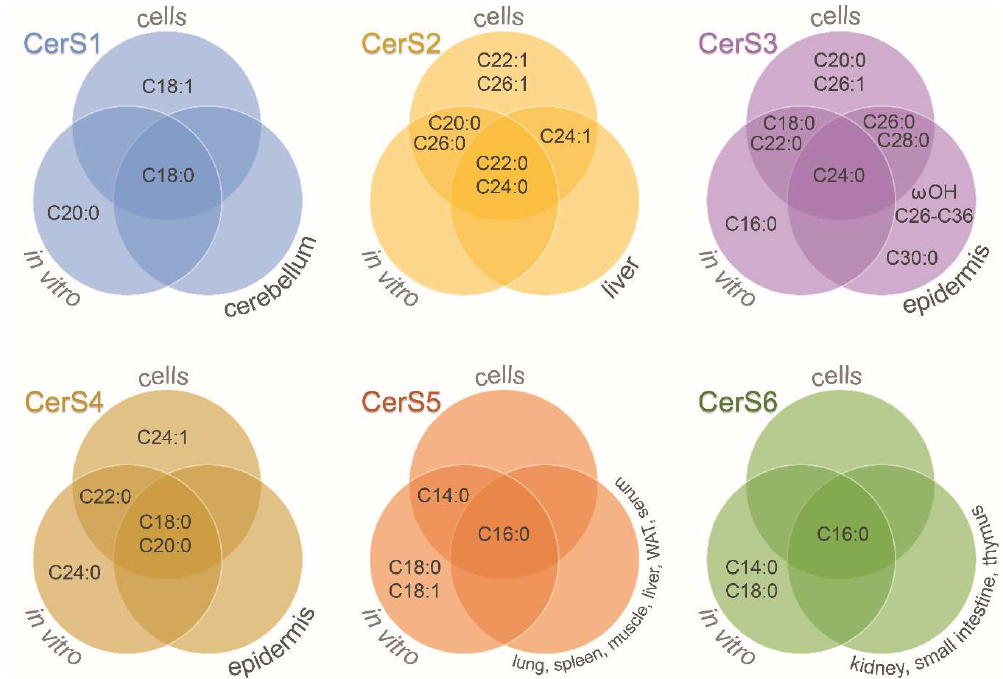
Figure 2. Ceramide synthases acyl-chain specificity. Venn diagrams show the results obtained for each of the six mammalian ceramide synthases (CerS) depending on the experimental approach: in vitro studies, overexpression or downregulation of CerS in cells, and selected tissues of CerS-deficient mice. WAT: white adipose tissue; ωOH: omega-hydroxylated acyl moieties. See more details in Table 1. Table 1. Ceramide synthases acyl-chain specificity. Ceramide synthases (CerS) acyl-CoA preferences for the synthesis of ceramides according to different experimental approaches.